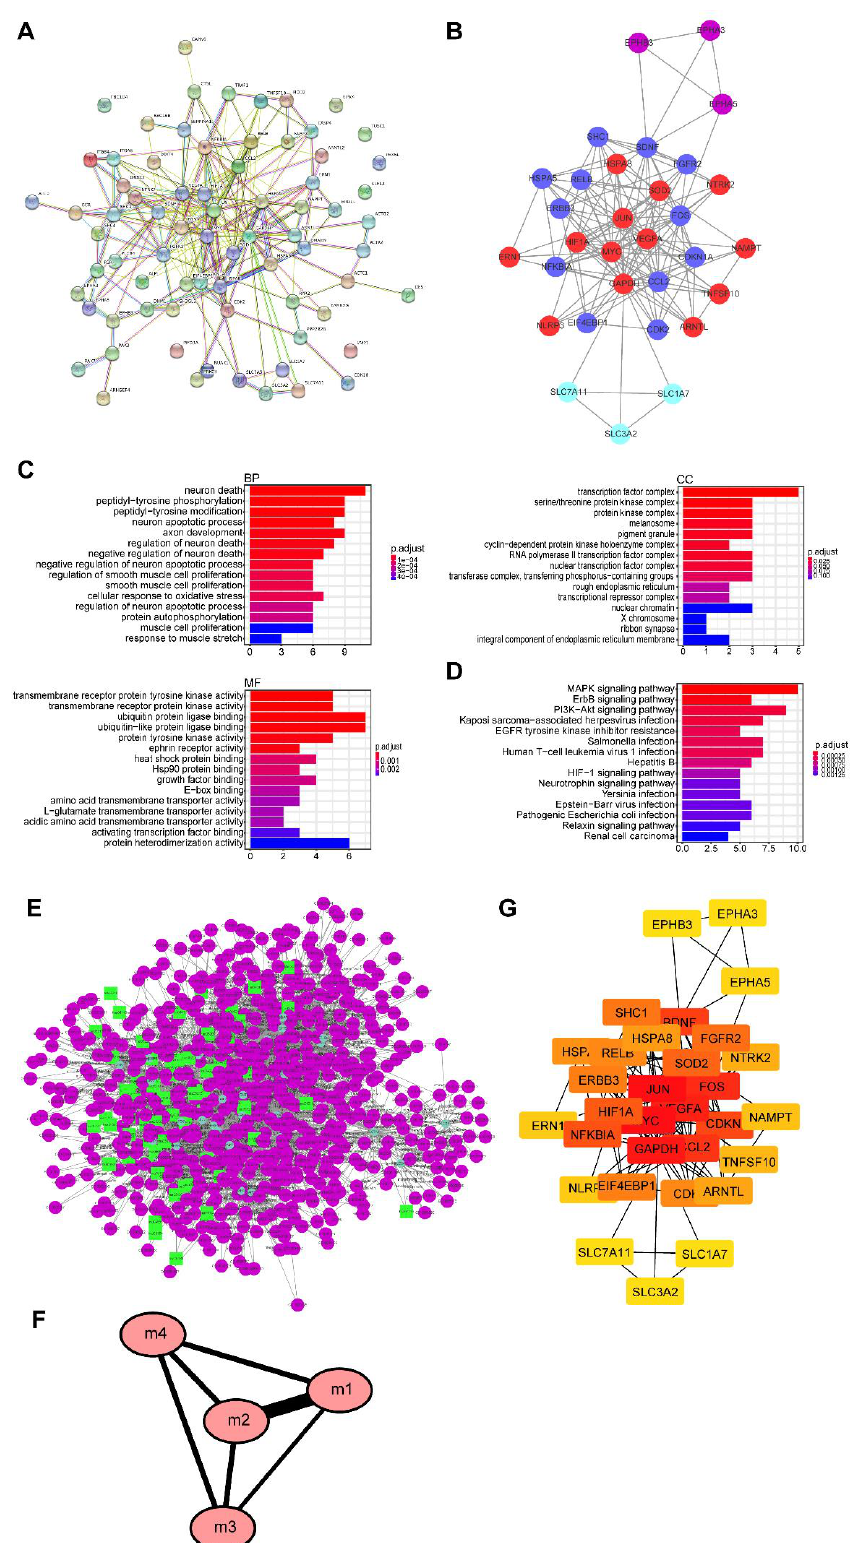
Figure 5. PPI network and its modular analysis. BP: biological process; CC: cell component; MF: molecular function. ( A ) PPI network. ( B ) Gene modules and related genes; blue: module one; red: module two; cyan-blue: module three; purple: module four. ( C ) GO enrichment analysis of modules. ( D ) KEGG pathway enrichment analysis of modules. ( E ) Crosstalk between gene function and signaling pathway; the green circles represent genes, the purple circles represent GO terms and the green boxes represent KEGG terms. ( F ) Interactions among the four modules. ( G ) Ten hub genes are identified.